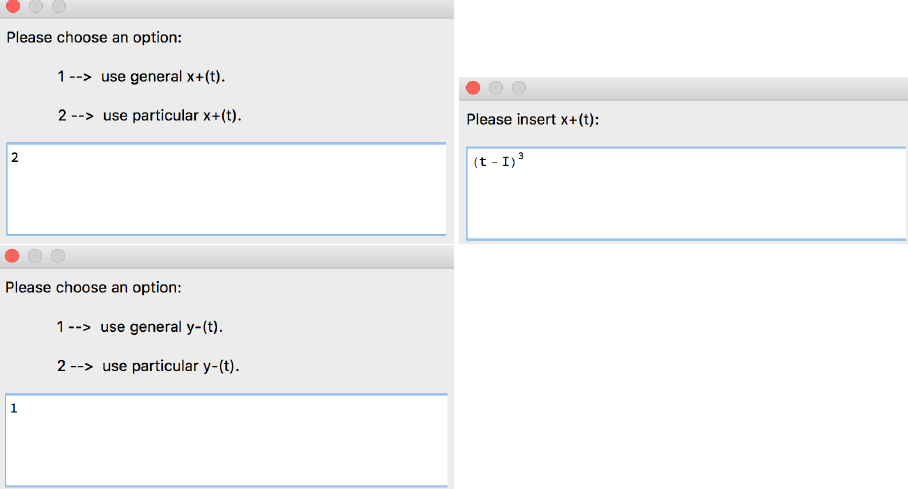
Figure 5. Part of the structure of the [SInt] algorithm corresponding to the input of x + and y − . The [SInt] algorithm gives the singular integrals presented in Figure 6.